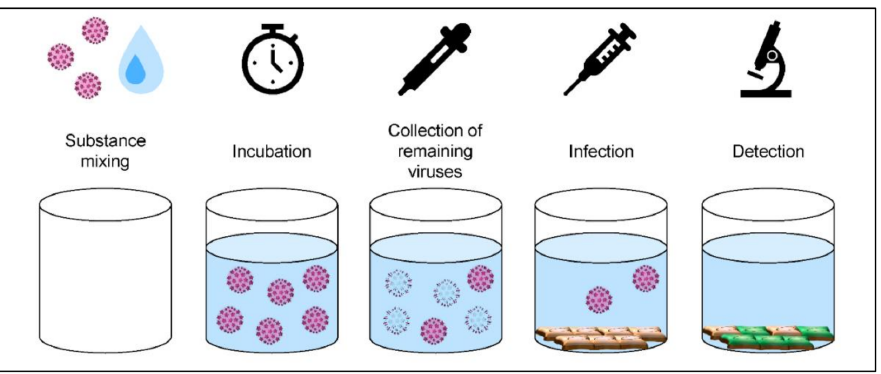
Figure 3. Quantitative suspension test using HPV16 pseudovirus. First, HPV16 pseudovirus (titer of at least 10 8 tissue culture infectious dose, 50% (TCID 50 /mL) and BSA (final concentration in the test procedure 0.3 g/L BSA) were mixed in equal volumes. This solution was then exposed to 8 volumes of the respective disinfectant (Table 1) and incubated at 20 ◦ C ± 2 ◦ C for the contact time indicated in Table 2. At the end of the contact time, cell culture media were added to the solution to stop the reaction. For determination of the virus titer after incubation with the respective disinfectants, 293TT cells (1 × 10 4 cells/well in 96-well plates) were incubated with 10 − 1 to 10 − 10 dilution series of HPV16 pseudovirus/disinfectant solution (n = 8 repeats for each dilution). Cells were analyzed after 48 h for GFP expression by fluorescence